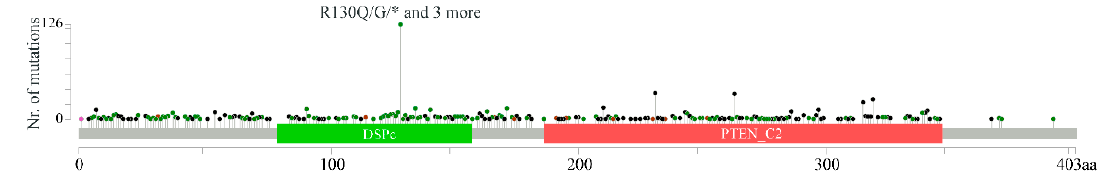
Figure 7. Type of mutations, frequency, and a ff ected PTEN domains across selected solid tumors. The 19 tumor types included in this analysis from cbioportal.org are melanoma, head and neck squamous cell carcinoma, non-small cell lung cancer (i.e., squamous cell and adenocarcinoma), mesothelioma, esophageal cancer, stomach cancer, colorectal cancer, cholangiocarcinoma, pancreatic cancer, liver cancer, bladder cancer, prostate adenocarcinoma, uterine cancer (i.e., endometrioid, serous, and carcinosarcoma), ovarian cancer, and invasive breast cancer. Green, missense; black, truncating; brown, inframe; purple, other types of genetic